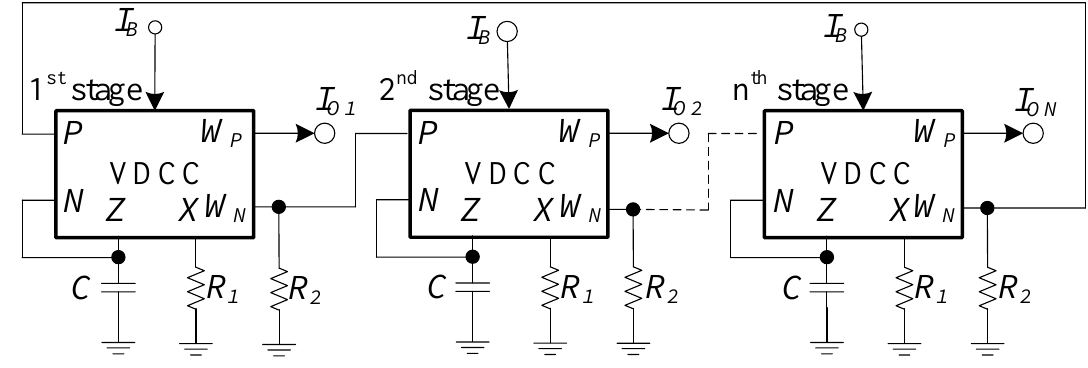
Figure 4. Proposed odd-phase MSO with high impedance at current output nodes.